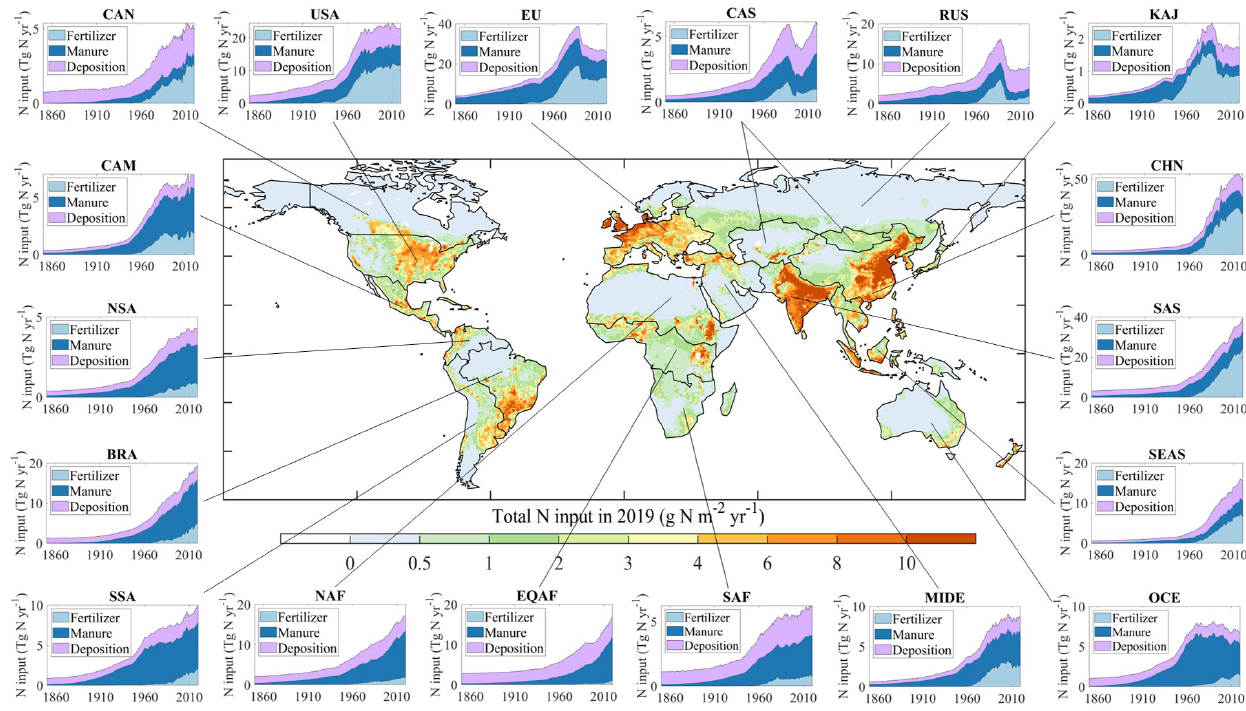
Figure 6. Long-term trends and variations in regional N inputs (synthetic fertilizer, livestock manure, and atmospheric deposition) to terres- trial ecosystems during the period from 1860 to 2019. The 18 regions are the USA (USA), Canada (CAN), Central America (CAM), northern South America (NSA), Brazil (BRA), southwestern South America (SSA), Europe (EU), Northern Africa (NAF), Equatorial Africa (EQAF), Southern Africa (SAF), Russia (RUS), Central Asia (CAS), the Middle East (MIDE), China (CHN), Korea and Japan (KAJ), South Asia (SAS), Southeast Asia (SEAS), and Oceania